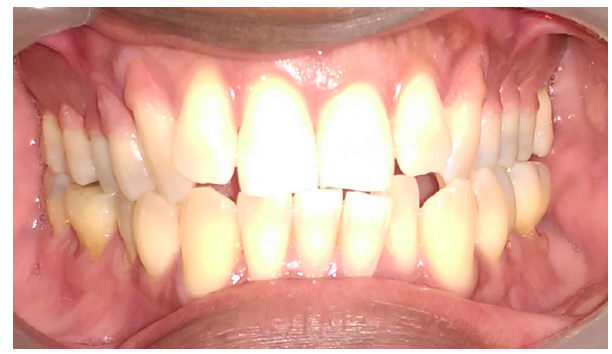
Figure 7. Final appearance of restored lesions.